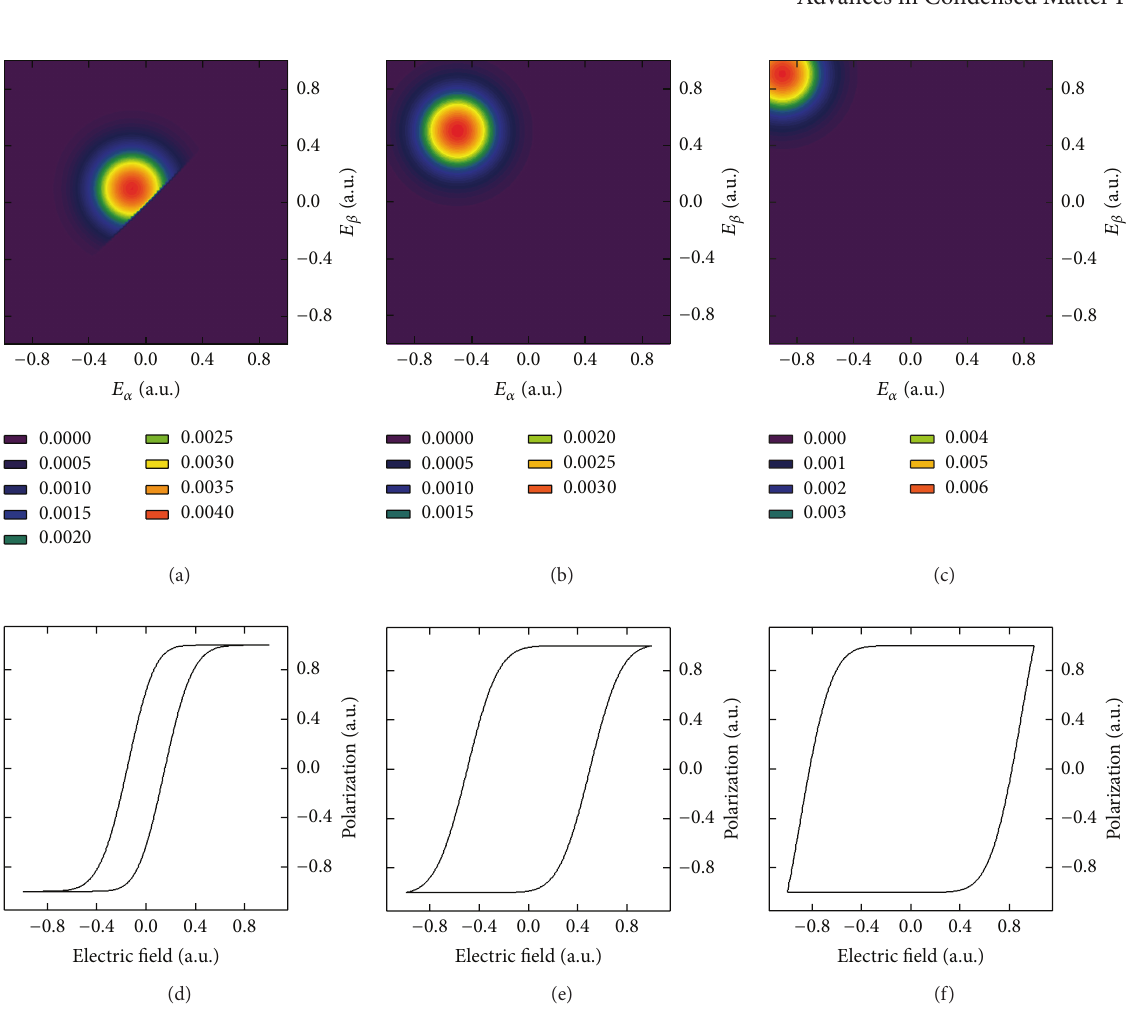
included on the plane. These changes suggest that